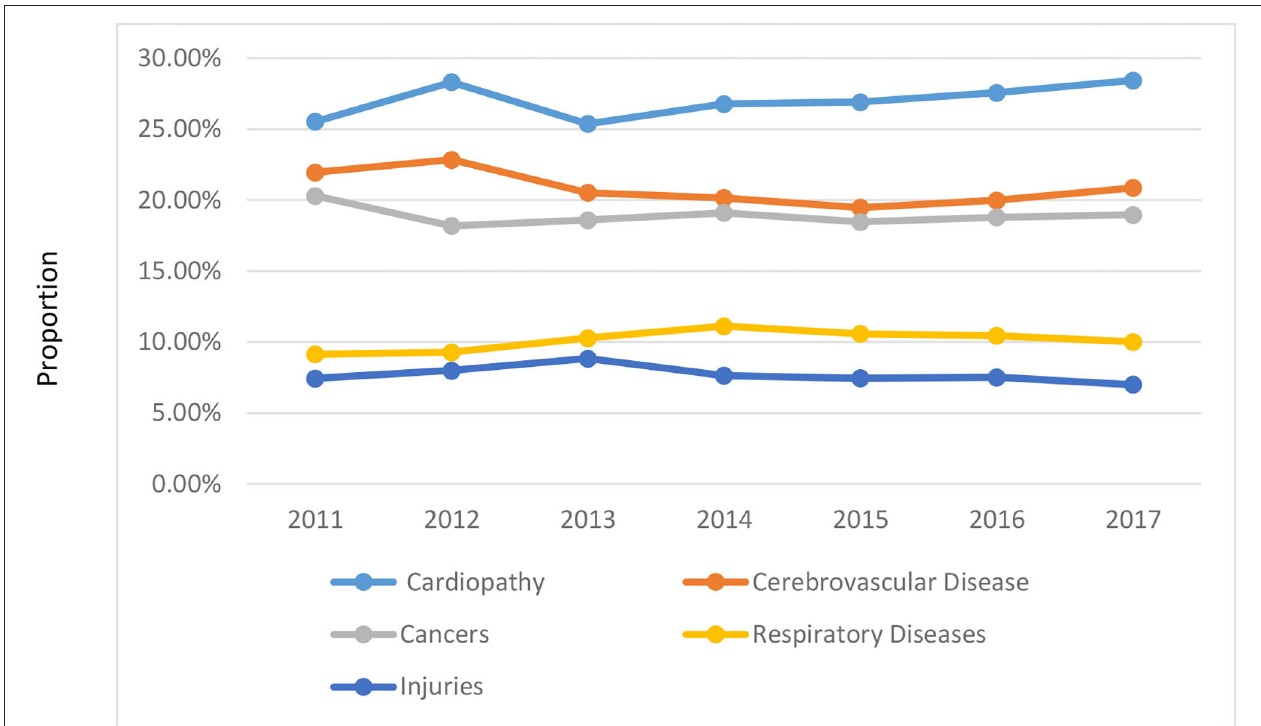
FIGURE 4 | The Trends of death cause of Z City